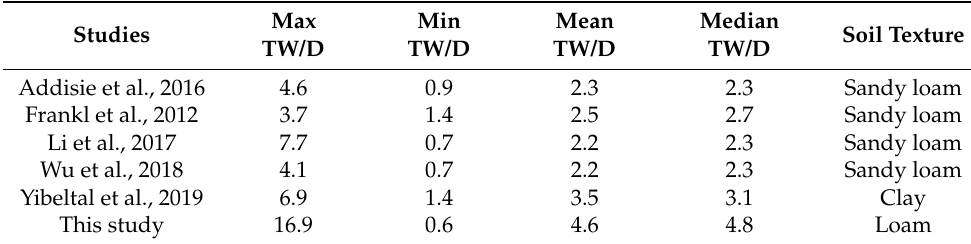
Table 4. The top width–depth ratios in different regions across the world.